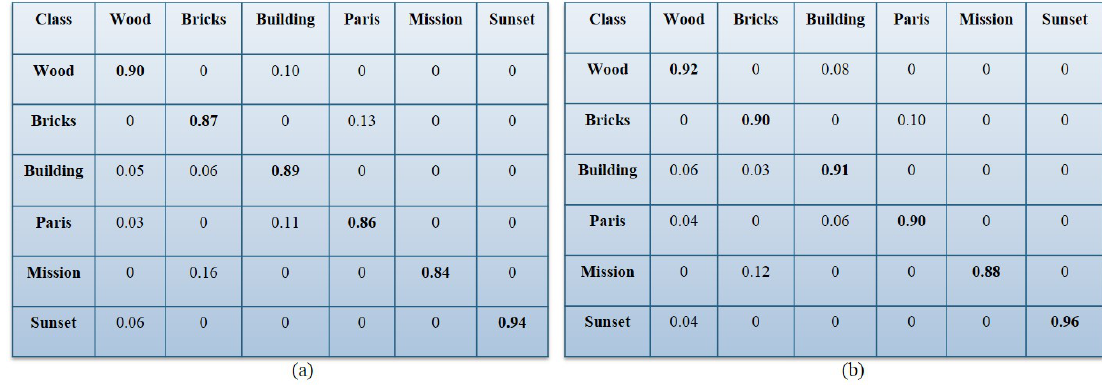
Figure 8. ( a ) Confusion Matrix for proposed method on UCSB dataset for image query and ( b ) Confusion Matrix for proposed method on UCSB dataset for video query.